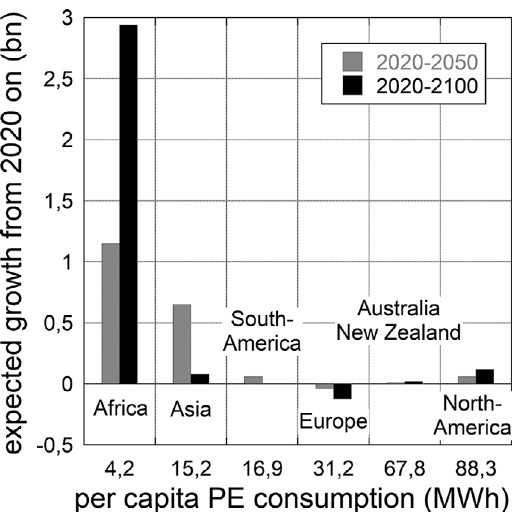
Fig. 1. – Expected population growth in different areas in two time periods —2020 to 2050 and 2020 to 2100 [1]— vs. per capita primary energy (PE) consumption of 2019